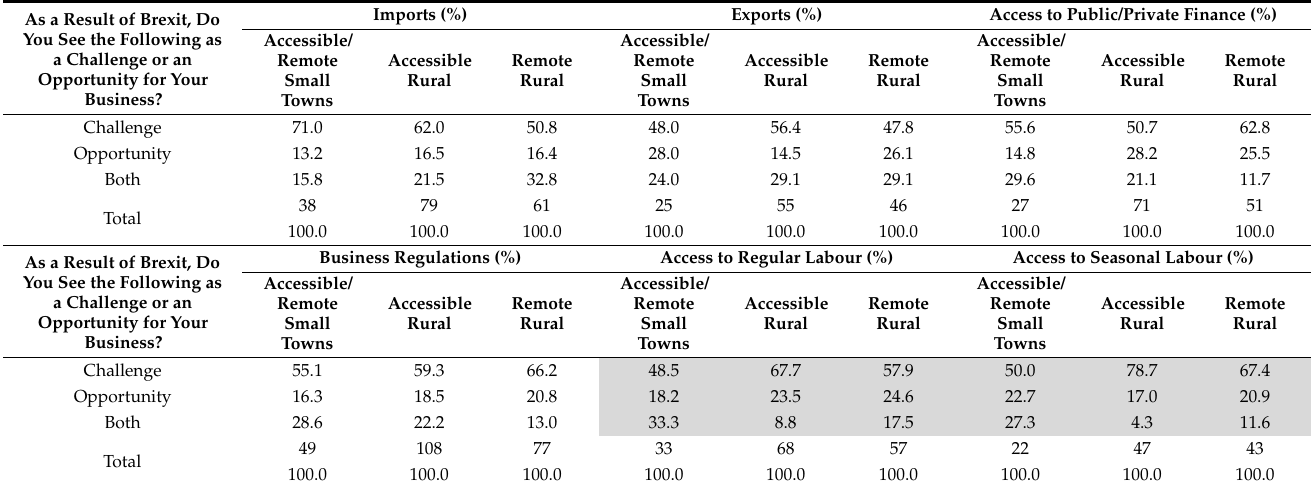
Table 9. Comparative analysis of challenges related to Brexit between non-land-based rural businesses that have a relationship with the landed estate sector in different rural classifications in